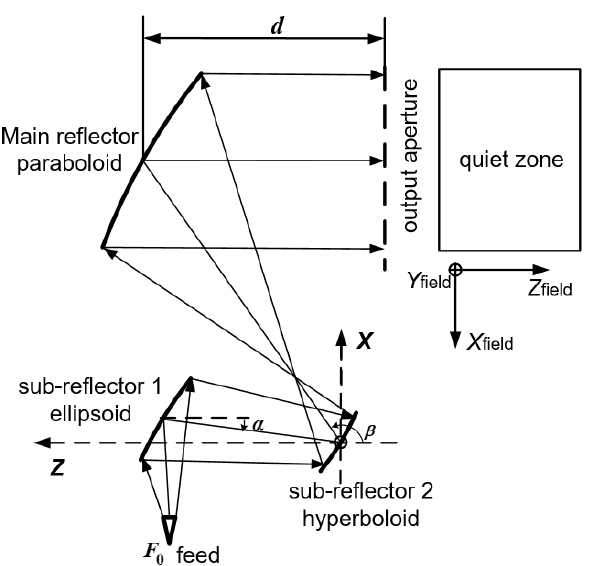
Figure 2. Geometry and design parameters of proposed tri-reflector compact antenna test range (CATR) with standard quadric surfaces.